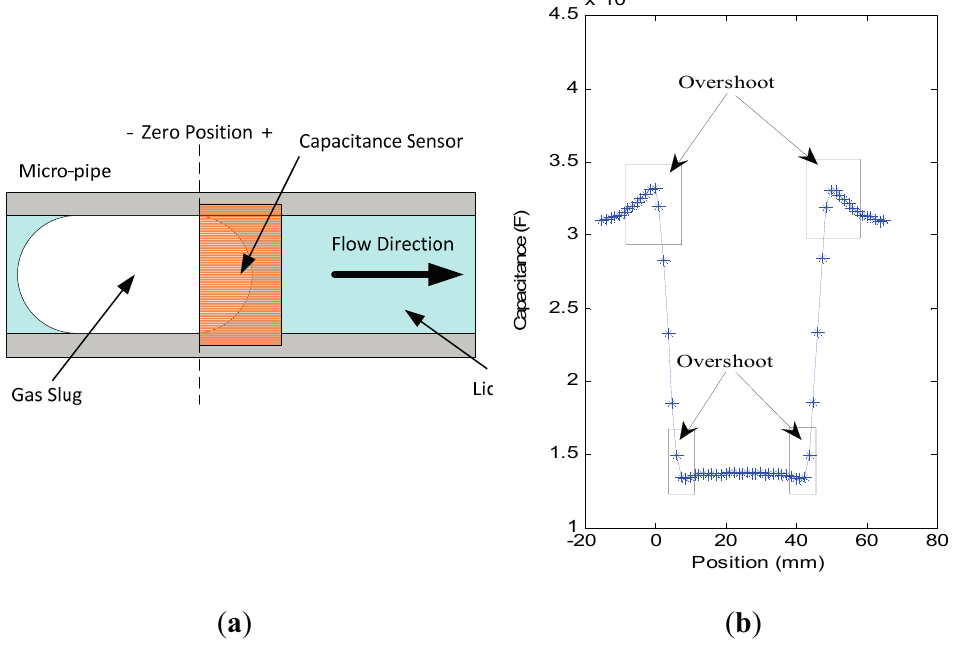
Figure 5. ( a )The ideal gas slug passing through the capacitance sensor; ( b ) Simulation results of a gas slug passing through the capacitance